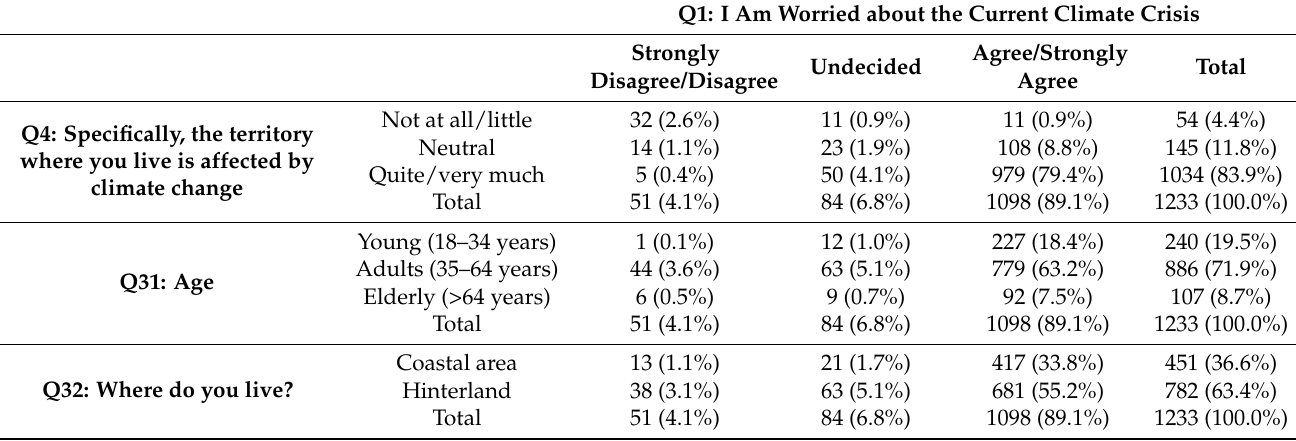
Table 3. Cross table of Q1 and Q4, Q31 and Q1, and Q32 and Q1 with frequencies (percentages) of the answers.